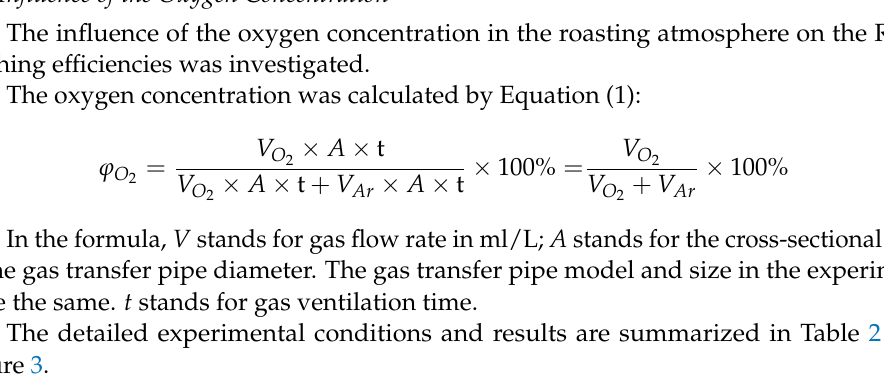
Table 2. Extraction efficiency of Ce, Tb, Y, Eu, and total rare earth under different oxygen concentra- tions (roasting temperature of 700 ◦ C, roasting time of 3 h, mass ratio of phosphor powder to